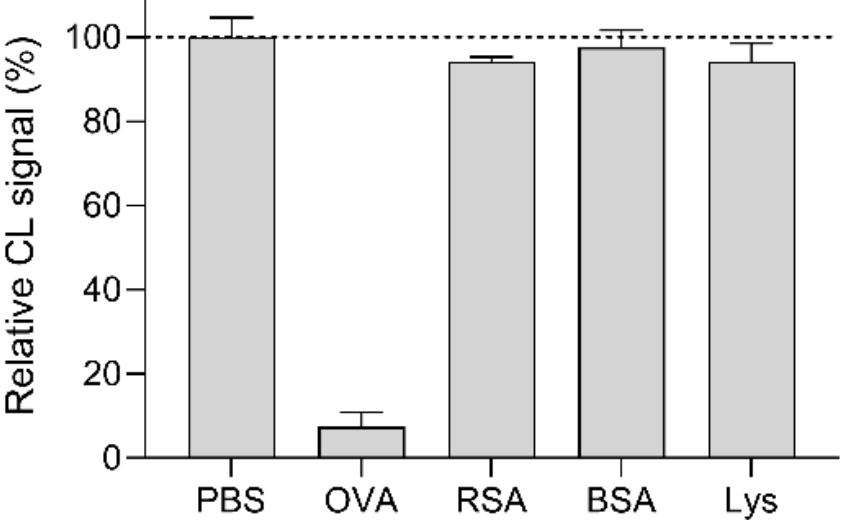
Figure 8. CL signals measured in the origami µPAD for an OVA-free standard solution (PBS) and 10 µg mL − 1 standard solutions of the potentially interfering proteins RSA, BSA, and Lys. For com- parison, the CL signal measured for a 10 µg mL − 1 OVA standard solution is reported. Each of the data are the mean ± SD of three measurements.